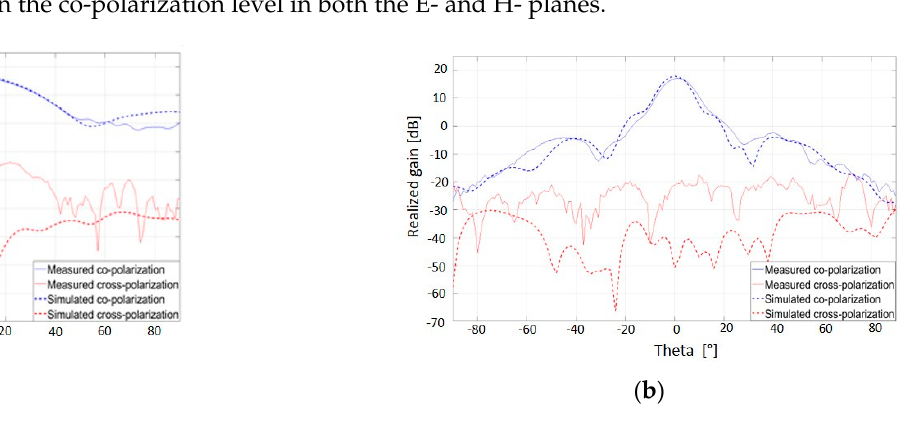
Figure 9. Measured and simulated co- and cross-polarization radiation patterns at 15 GHz of the 16-slot waveguide antenna: ( a ) E-plane and ( b ) H-plane.